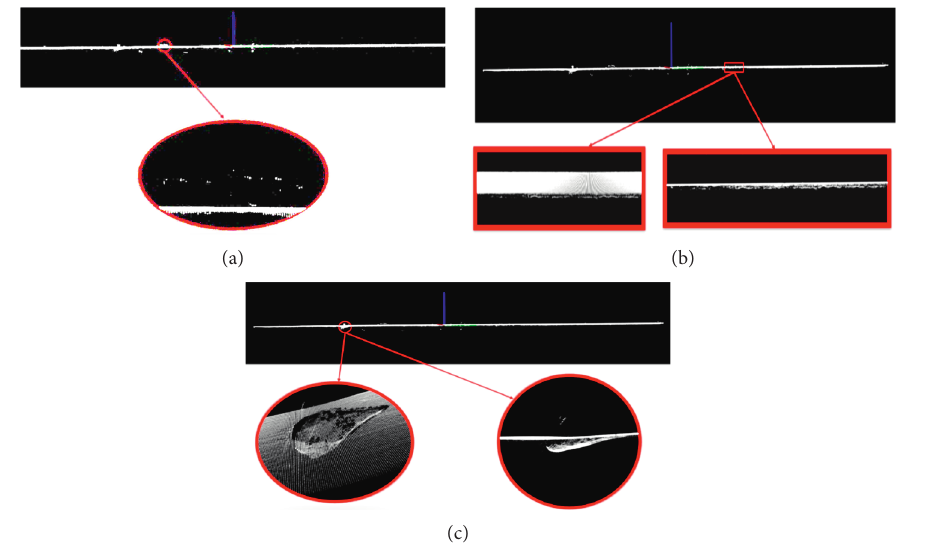
Figure 2: Types of noise points on the surface of fatigue rollers. (a) YZ plane view of isolated point, (b) different angle views of noise on the chamfered edge, and (c) different angle views of outlier